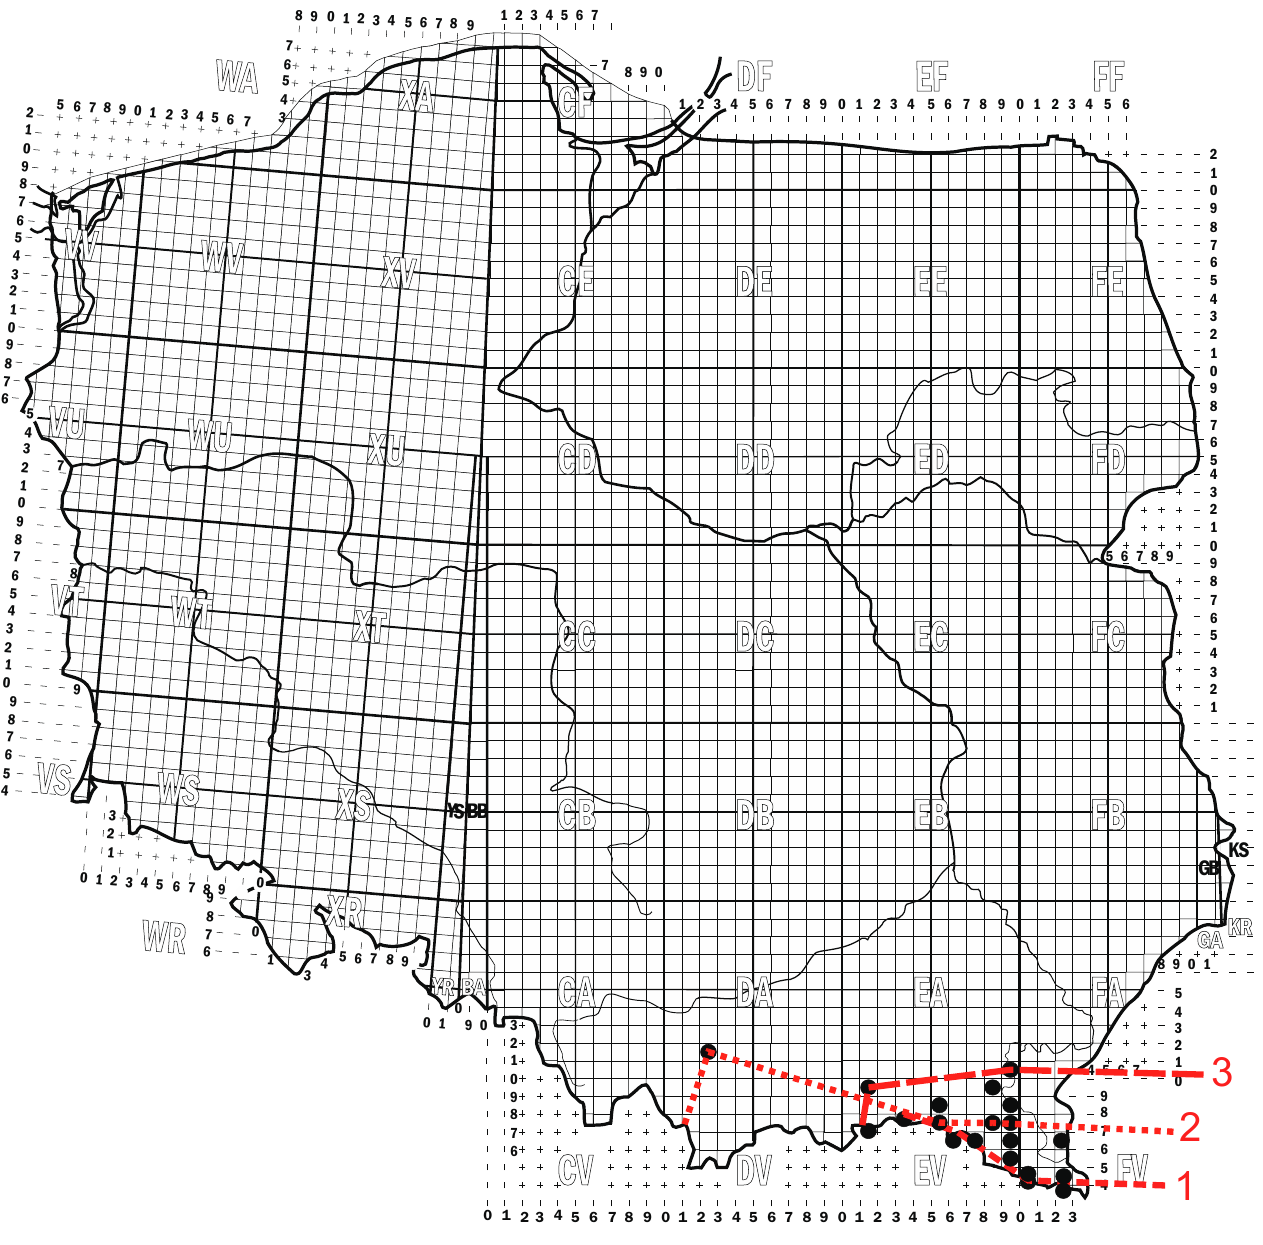
Figure 4. Geographical distribution of species which have their north-western range of occurrence in Poland: 1– Trachytes splendida , 2— Polyaspinus schweizeri , 3— Urodiaspis stammeri.